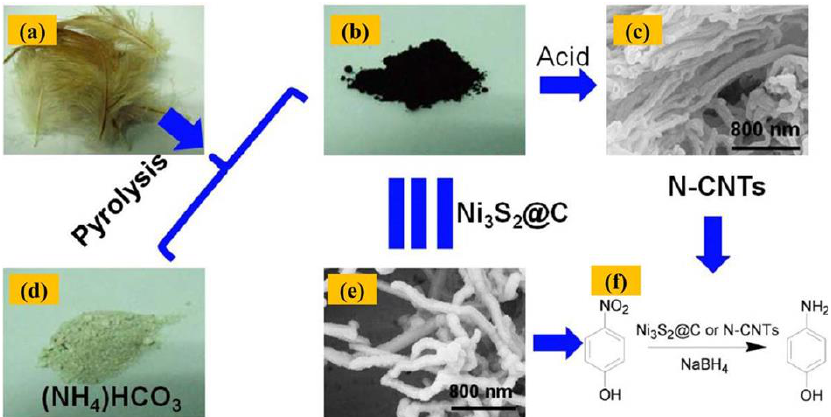
Figure 6. The several steps involved in creating CNTs from chicken feathers are represented sche- matically. Photograph of chicken feathers ( a ) in white and black products created in the autoclave in ( b ) and ( c ). Ni 3 S 2 @C and N-CNT images captured with a FESEM in ( d ) and ( e ), respectively. ( f ) The catalytic reaction of the synthesized Ni 3 S 2 @ C or N-CNTs. Adapted with permission from ref. [28].